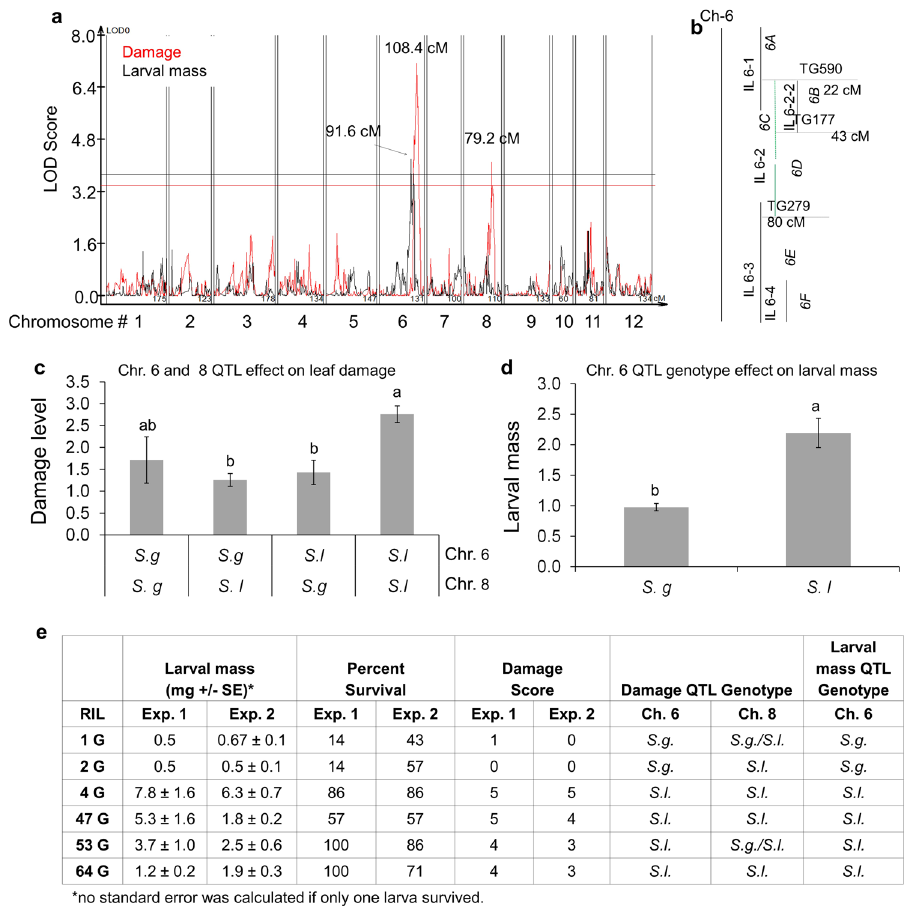
Figure 4. Quantitative trait loci for S. galapagense RILs. ( a ) Two QTLs for leaf damage (red line) were found, one on chromosome 6 and one on chromosome 8. A larval mass QTL (black line) was found on chromosome 6. A 95% confidence level was used. ( b ) Representation of the common region between susceptible IL 6-2 and the QTLs on chromosome 6. The dashed line contains the larvae mass QTL on BIN 6D , and part of the leaf damage QTL in BIN 6E . The approximate position of the flanking markers is shown in centimorgans of the S. lycopersicum genetic map (Tomato Expen 2000 map, www.solgenomics.net). ( c ) Leaf damage in RILs that were grouped on the basis of having the S. lycopersicum ( S.l .) or S. galapagense ( S.g .) alleles for the QTL on chromosomes 6 or 8. Bars represent means ± SE. Different letters indicate significant differences, p < 0.05, HSD test. ( d ) Larval mass in RILs separated by having the S. lycopersicum ( S.l .) or S. galapagense ( S.g .) allele for the QTL on chromosomes 6. Different letters indicate significant differences, p < 0.05, HSD test. ( e ) Larval mass, percent survival, and damage score from an independent confirmation of recombinant lines that showed high (1 G and 2 G) or low (4 G, 47 G, 53 G, and 64 G) CPB resistance in Fig. 3. The plant genotype, S. lycopersicum ( S.l .), S. galapagense ( S.g .), or heterozygous ( S.g./S.l .) at the site of the identified resistance QTL is